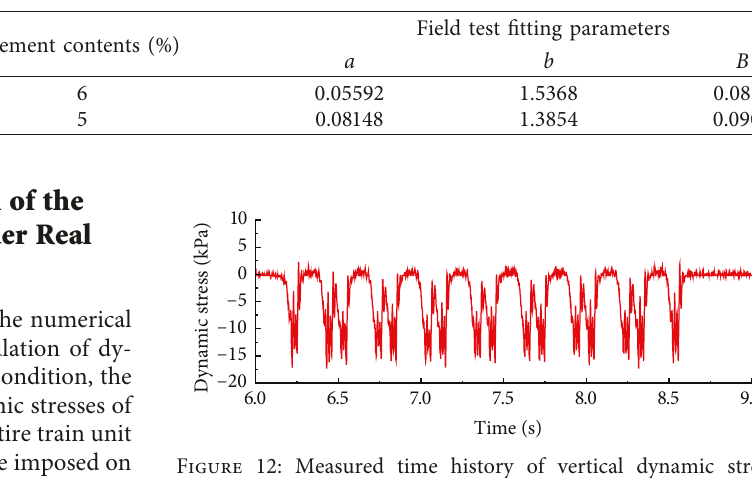
Table 4: Modified model parameters of the improved CWG based on the field cyclic loading